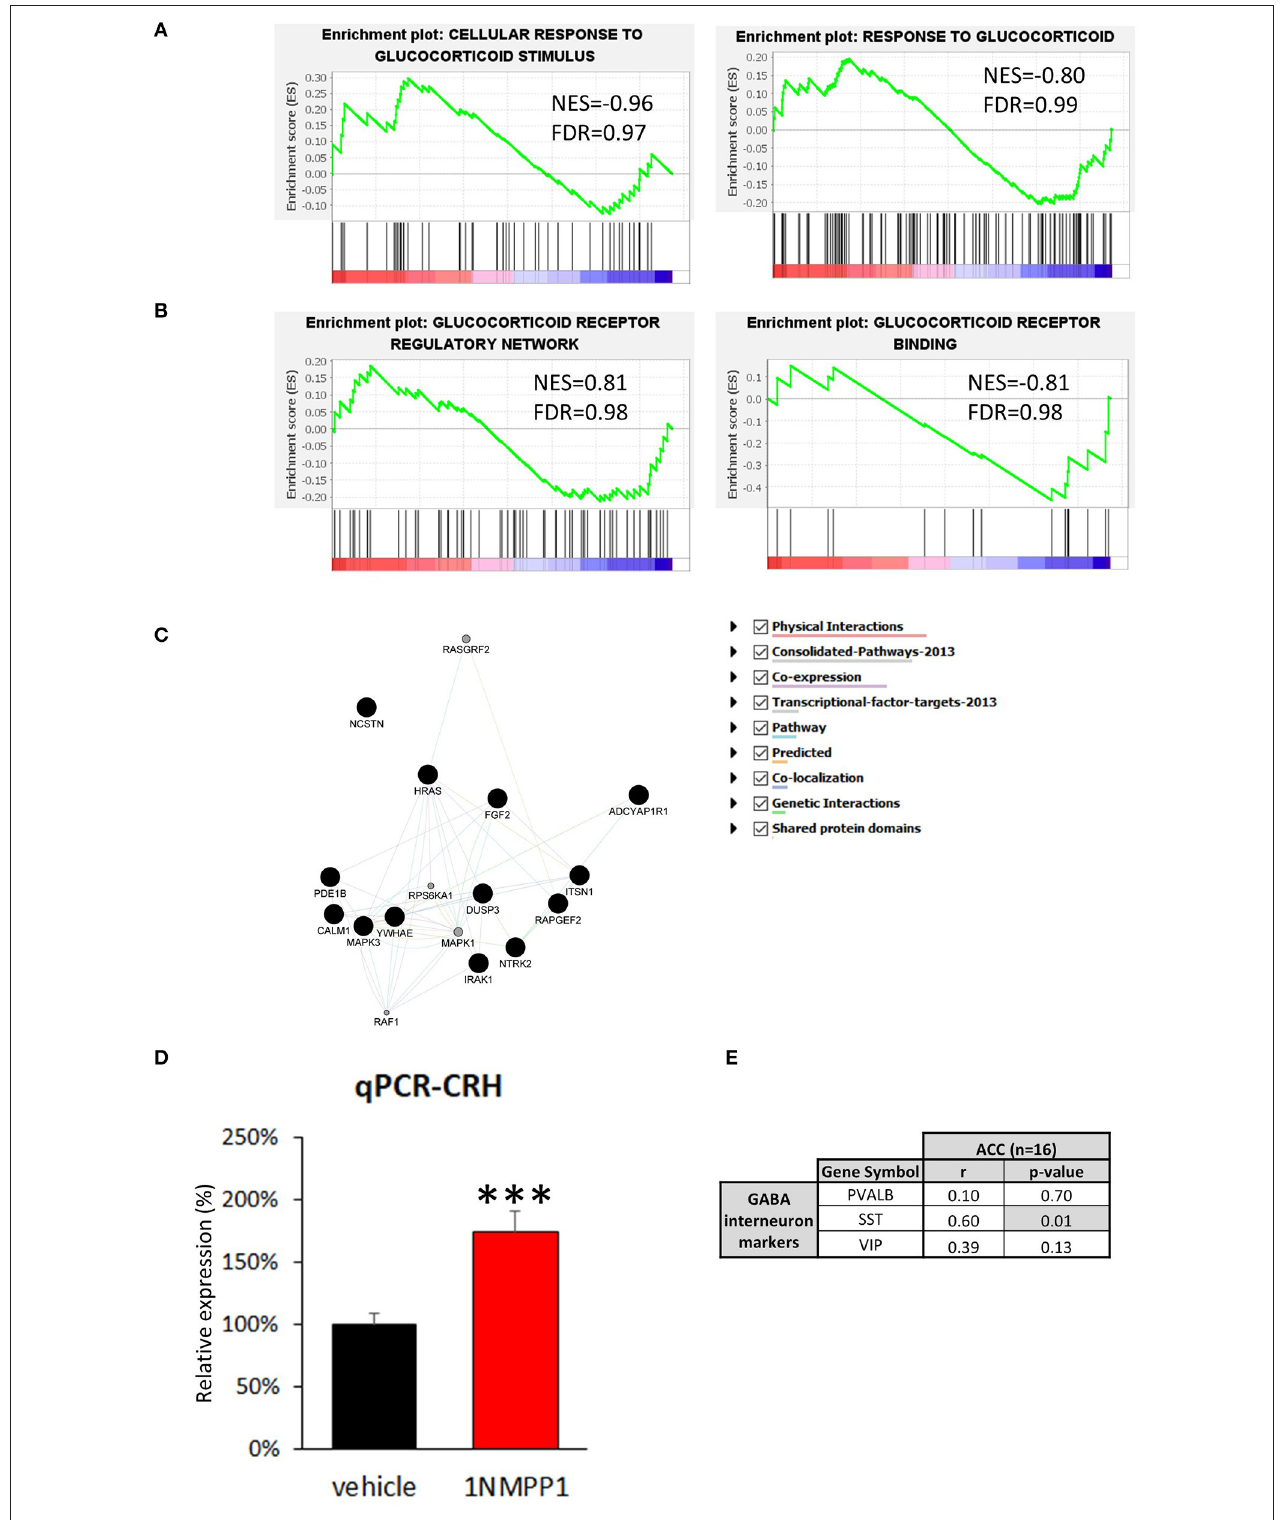
FIGURE 4 | Possible upstream regulator of CRH. (A,B) GSEA results of four glucocorticoid-related signaling pathways. The enrichment plots of upregulated (upward curve) and downregulated (downward curve) genes in the relevant pathways do not differ from random distributions, hence they do not show significant differences